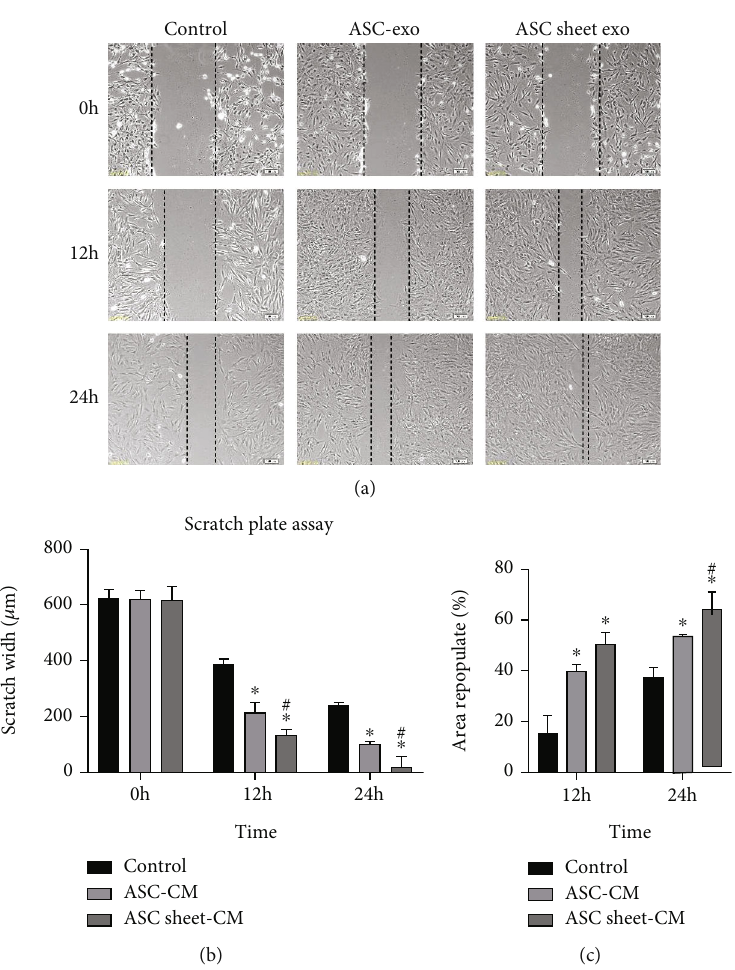
Figure 12: E ff ects of ASC-exo and ASC sheet-exo on the migration of ECs in scratch plate assay. (a) Representative images of ECs scratch wound assay at 0 h, 24h, and 48 h. Scale bars: 100 μ m. (b) The widths of the scratches at 0h, 24 h, and 48h. (c) The rates of area repopulation at 24h and 48h. ∗ p < 0 : 05 , versus the control group; # p < 0 : 05 , versus the ASC-exo group.